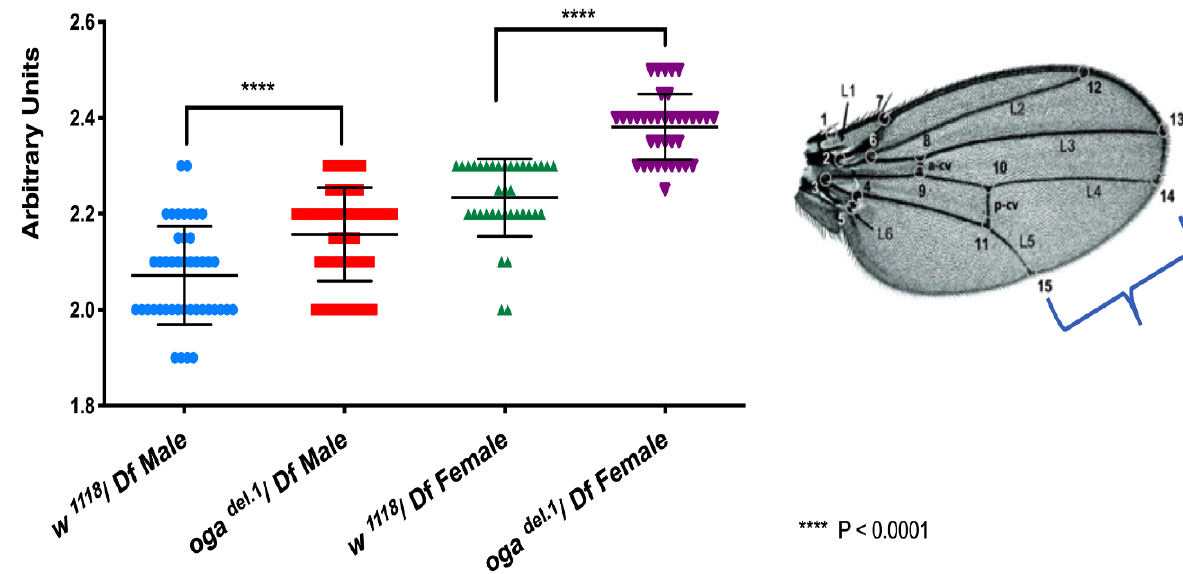
Figure 2. oga del.1 mutants have increased body size. The wings of 8-day-old adult flies that have been kept at 25 ◦ C were used for this assay. The distance between L4 and L5 wing veins was measured. Both female and male oga del.1 mutants were larger than wild type flies. Statistical analysis was performed using unpaired t -test. **** = p < 0001.